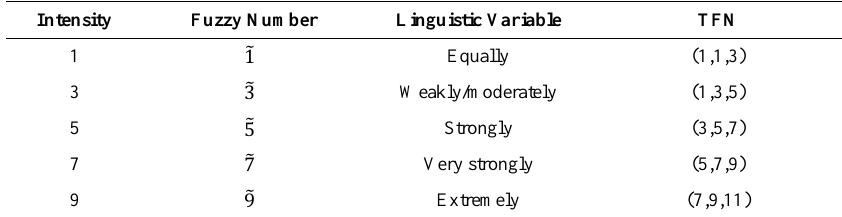
Table 3. Triangular Fuzzy Number